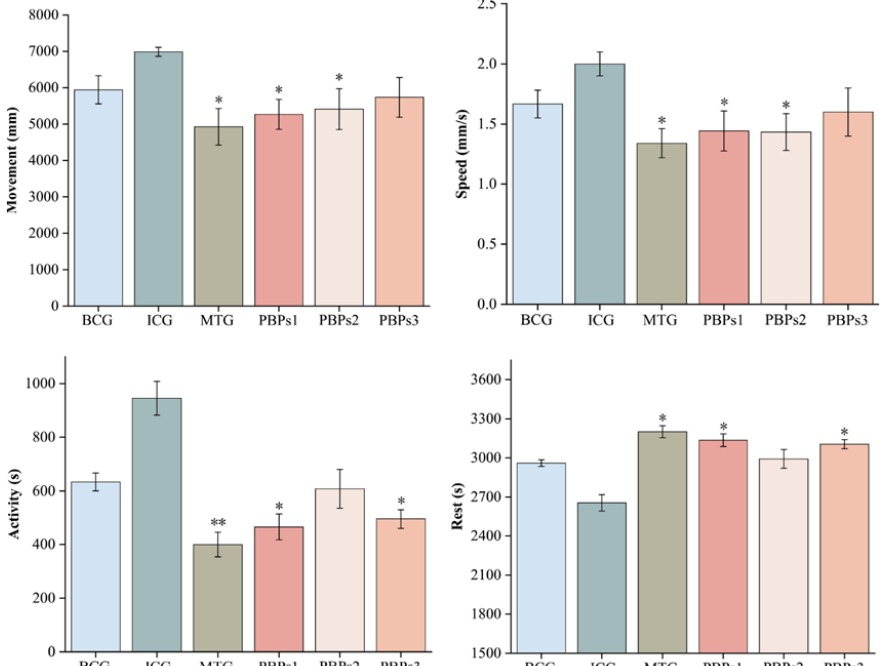
Figure 1. Changes in behavioral indicators of zebrafish after PBPs1 (0.25 mg/mL), PBPs2 (0.25 mg/mL) and PBPs3 (0.25 mg/mL) treatment. The p -values for each group were calculated by comparison with the ICG. Blank control group (BCG), normal growth of zebrafish without adding any drugs; Insomnia control group (ICG); Positive drug (melatonin) group (MTG). Data are expressed as mean ± SD. (Student t-test, * p < 0.05, ** p < 0.01, n = 8).